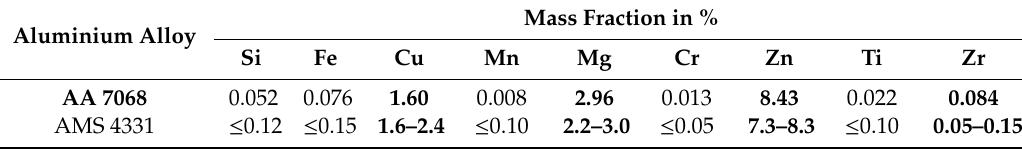
Table 1. Mass fraction of alloying elements of the investigated material in